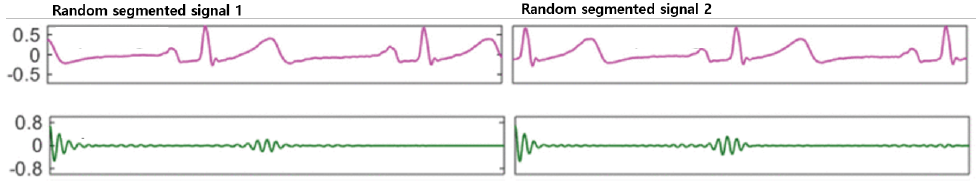
Figure 6. Multi-resolution representation of two randomly segmented windows of an ECG signal.